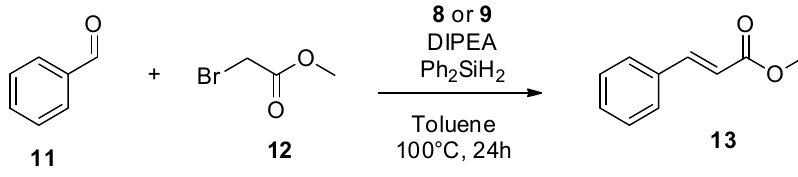
Scheme 2. The Witting reaction of 11 and 12 to afford cinnamate 13 . Table 3. Catalytic Wittig reaction: yields of methyl cinnamate ( 13 ) over the different cycles. Entry